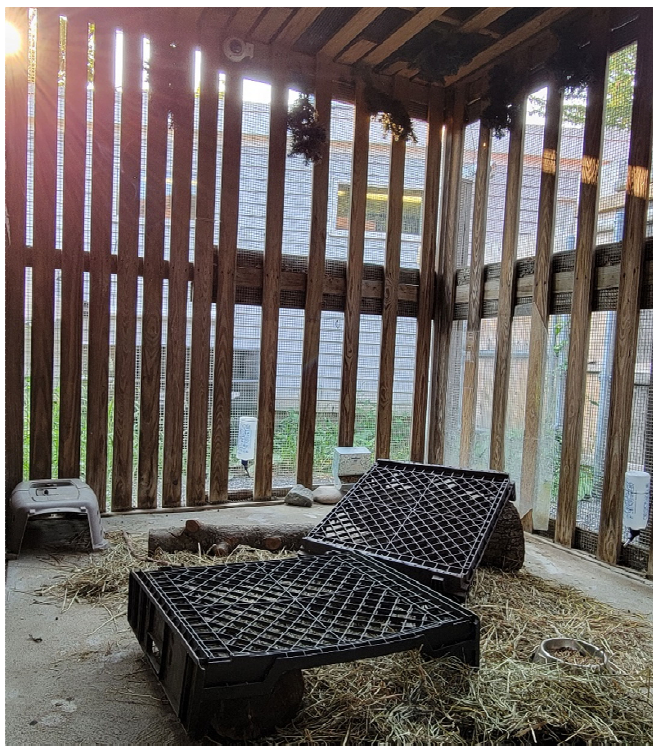
Figure 2. Outdoor breeding pen. When rabbits move here for breeding, they are moved in their hide boxes which remain in the pen with them to provide additional cover.